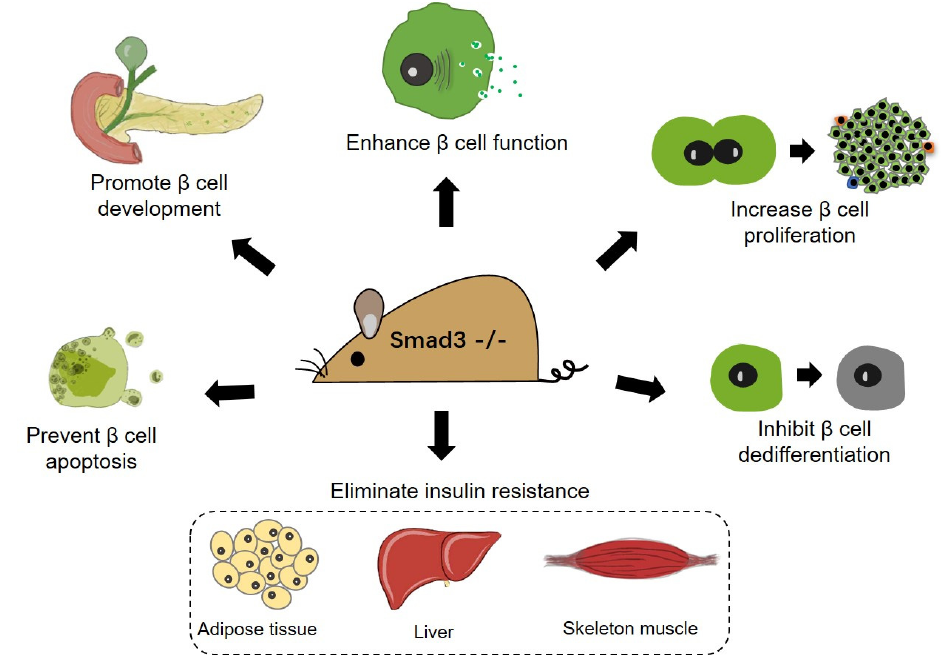
Figure 2. Benefits of Smad3 deficiency on β cell biology and insulin resistance. Smad3 deficiency in mice promotes β cell development, augments β cell function (by elevating insulin synthesis and GSIS), enhances β cell proliferation in response to systemic insulin demand, and suppresses/eliminates β cell apoptosis, β cell dedifferentiation, and insulin resistance in conditions of T2DM.